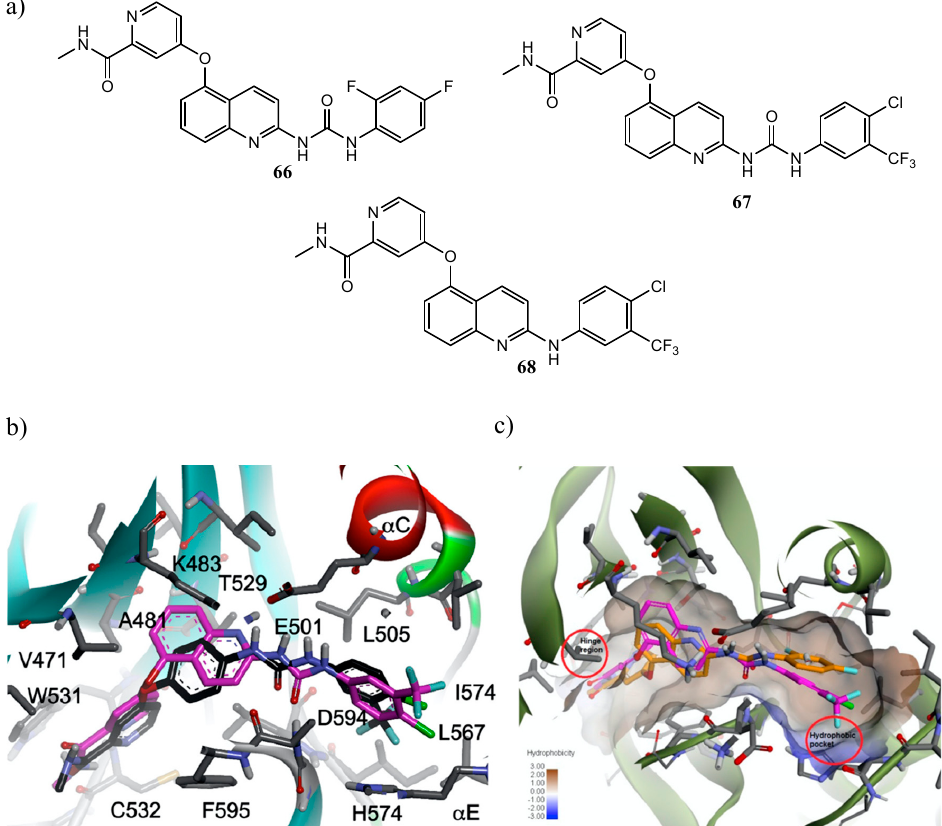
Figure 36. ( a ) Quinoline inhibitors of Raf compared with the reference compound sorafenib ; ( b ) overlay of the docked pose of compound 67 (magenta) and co-crystalized sorafenib (black) in the catalytic kinase domain of BRAF V600E (PDB id: 1UVJ); ( c ) superimposition of the docked pose of compound 67 (magenta) and 66 (orange) in the catalytic kinase domain of BRAF V600E (PDB id: 1UVJ) [141,142]. Li et al. developed quinoline derivative 69 (Figure 37) with urea and a 4-fluoro-3- (trifluoromethyl)phenyl moieties, as sorafenib. It exhibited higher antiproliferative activity than the reference compound, against Hep G2, A549 and KCC-853 cancer cell lines and also a higher inhibitory activity against C-Raf (for 69 C-Raf IC 50 = 8.7 nM; for sorafenib C-Raf IC 50 = 28.5 nM) [143].